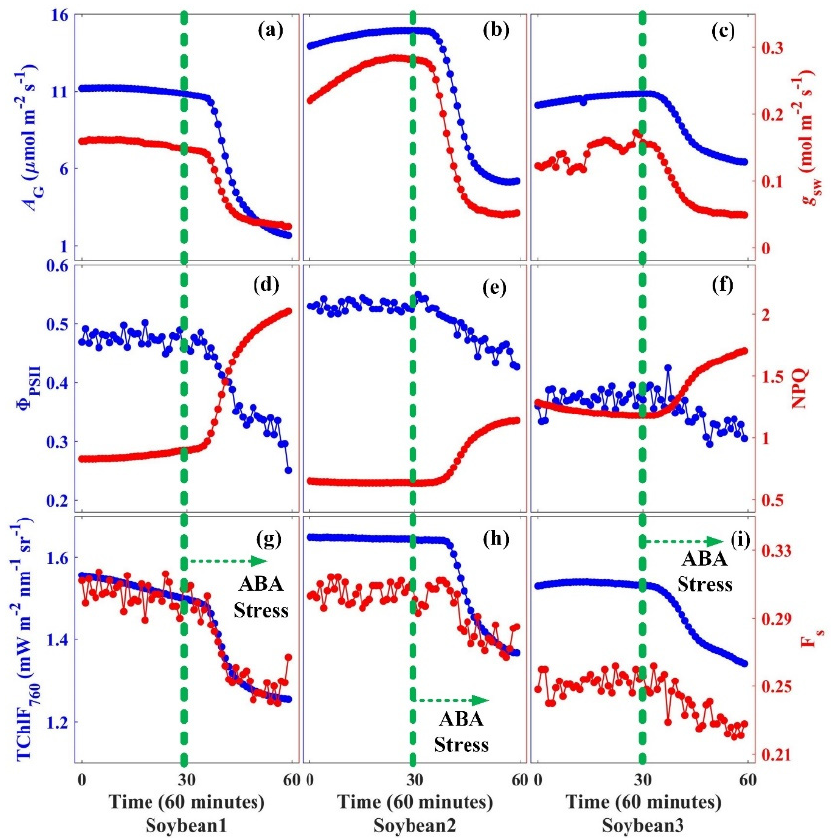
Figure 5. Variation in soybean gross carbon assimilation ( A G , µ mol m − 2 s − 1 , ( a – c ), left y -axis), stomatal conductance to water vapor ( g sw , mol m − 2 s − 1 , ( a – c ), right y -axis), quantum efficiency of photosystem II ( Φ PSII , ( d – f ), left y -axis), nonphotochemical quenching (NPQ, ( d – f ), right y -axis), total fluorescence radiance at 760 nm measured from both sides of leaves (TChlF 760 , mW m − 2 nm − 1 sr − 1 , ( g – i ), left y -axis), and light-adapted steady-state PAM fluorescence (F s , ( g – i ), right y -axis) for pre-treatment and post-treatment of ABA under irradiance of 800 µ mol m − 2 s − 1 . The vertical green dashed line indicates the start of the ABA treatment. The three columns represent three individual soybean leaves. n ABA = 30 for each leaf.